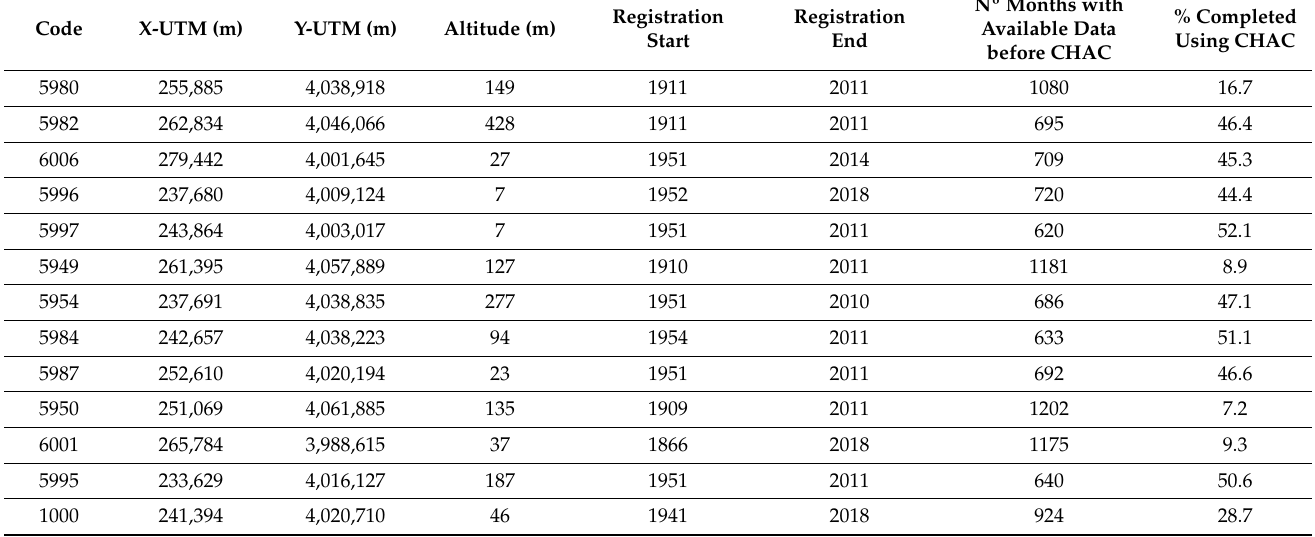
Table 1. Rainfall stations whose series were completed using the software CHAC. Period 1910/11– 2017/18. (Coordinates referred to UTM projection, zone 30, datum WGS84) .